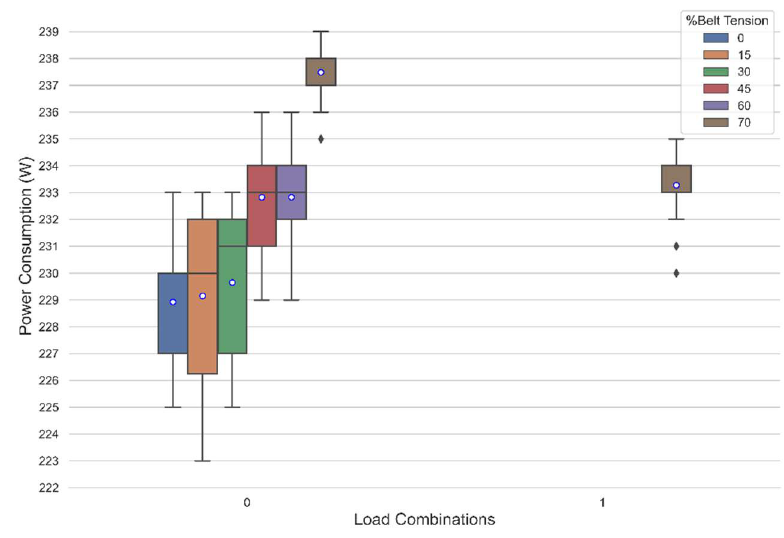
Figure 8. Effect of belt tensions (0–70%) and load on conveyor motor driver power consumption. Table 4. Dynamic case results for 70% belt